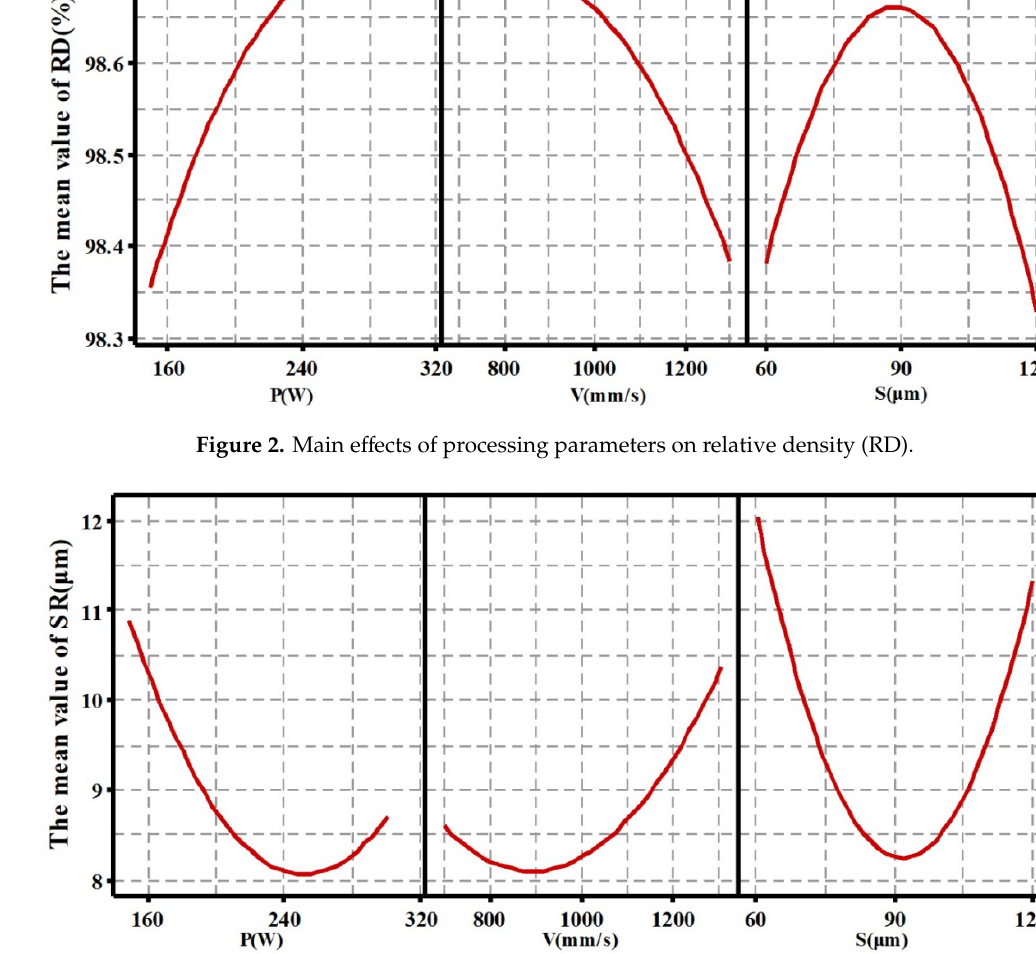
Figure 3. Main effects of processing parameters on surface roughness (SR).